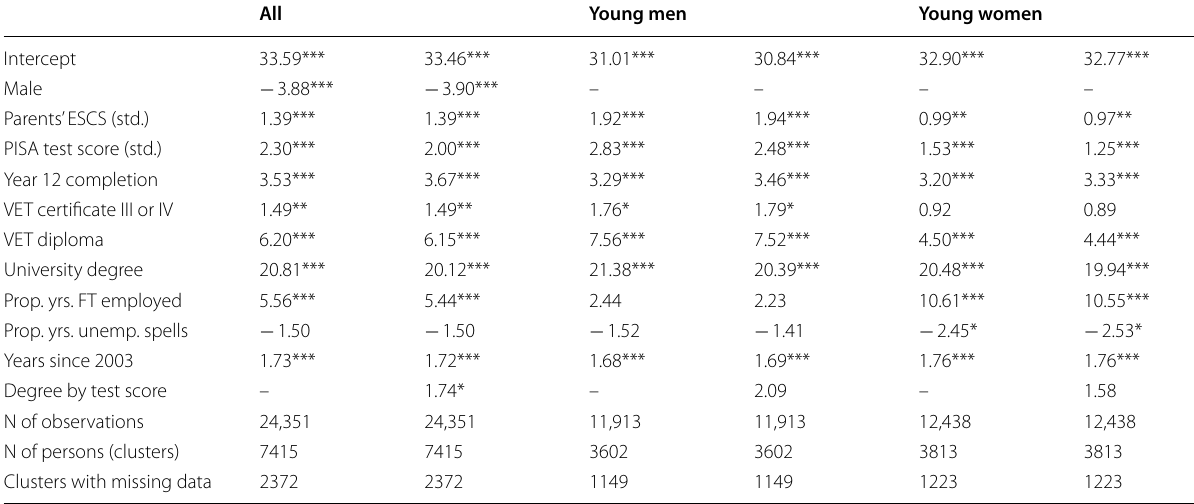
Regression coefficients from repeated design analyses. Full-time study observations excluded. Weighted for sample selection and attrition ESCS economic, social and cultural status, VET vocational educational and training, FT full-time, prop. yrs. FT employed proportion of years since 2003 with full time employment, prop. yrs. unemp. spells proportion of years since 2003 with any spell of unemployment